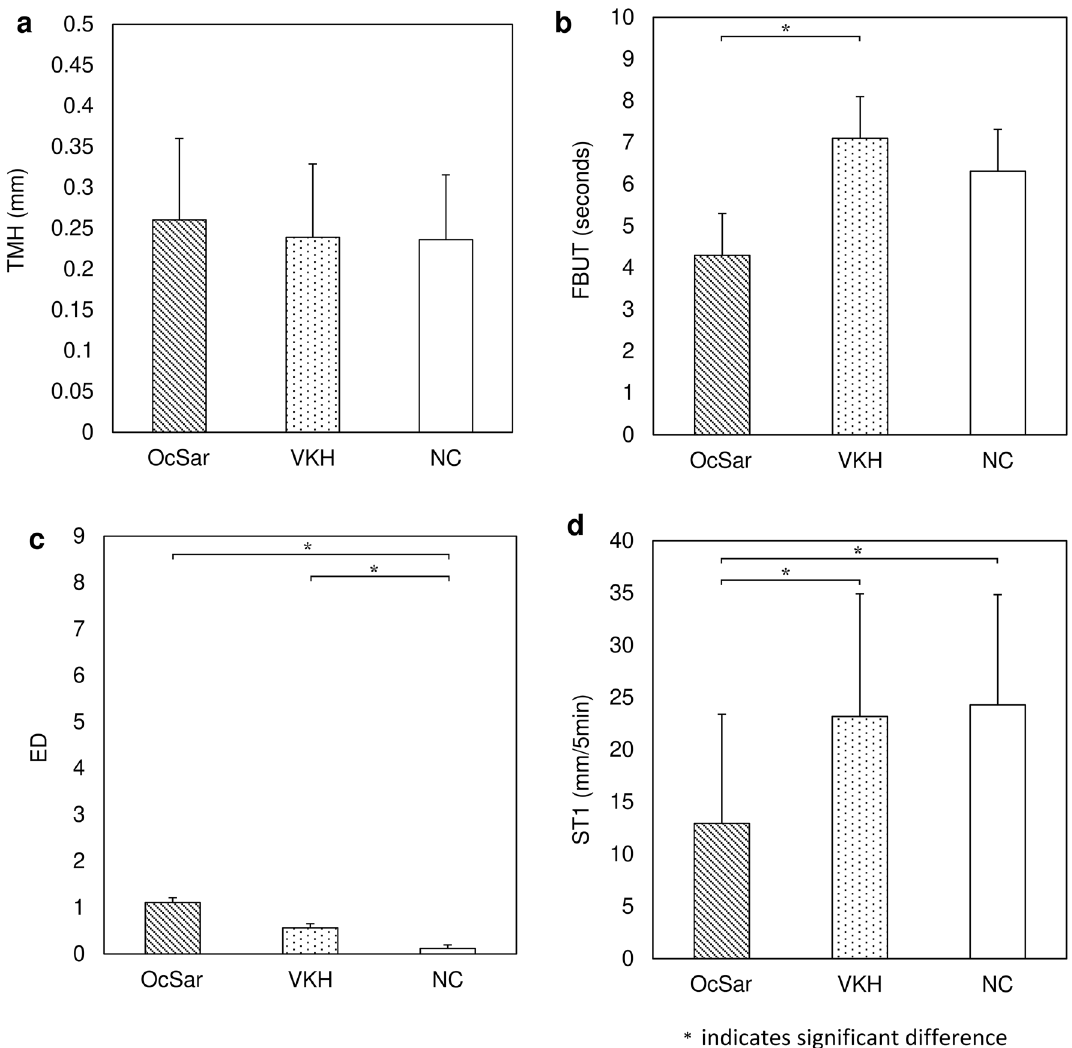
Figure 1. ( a ) Comparison of tear meniscus height (TMH, mm) between the ocular sarcoidosis (OcSar) group (0.26 ± 0.10 mm), Vogt–Koyanagi–Harada disease (VKH) group (0.24 ± 0.09 mm), and normal control (NC) group (0.24 ± 0.08 mm) (all values are mean ± SD). No statistical difference was found. ( b ) Comparison of fluorescein breakup time (FBUT, seconds) between the OcSar group (4.3 ± 2.5 s), VKH group (7.3 ± 2.9 s) and OcSar group (6.3 ± 3.1 s) (all values are mean ± SD). Significant differences were found between the one of 3 groups [ P = 0.002 (OcSar vs. VKH), P = 0.057 (OcSar vs. NC), and P = 0.527 (VKH vs. NC)]. ( c ) Comparison of keratoconjunctival epithelial damage (ED) between the OcSar group (1.1 ± 1.1), VKH group (0.7 ± 0.8), and NC group (0.1 ± 0.3) (all values are mean ± SD). There were significant differences between the two of 3 groups [ P = 0.358 (OcSar vs. VKH), P = 0.001 (OcSar vs. NC), and P = 0.040 (VKH vs. NC)]. ( d ) Comparison of the Schirmer 1 test results (ST1, mm/5 min) between the OcSar group (12.9 ± 10.5 mm), VKH group (21.5 ± 12.1 mm), and NC group (24.3 ± 10.5 mm) (all values are mean ± SD). The ST1 values in the OcSar group were significantly lower than those in the VKH group and NC group [ P = 0.004 (OcSar vs. VKH), P = 0.001 (OcSar vs. group (7.3 ± 2.9 s) ( P = 0.002), yet no significant difference in mean FBUT was found between the OcSar group (4.3 ± 2.5 s) and the NC group (6.3 ± 3.1 s) ( P = 0.057) (Fig. 1b). There was no significant difference in the mean ED value between the OcSar group (1.1 ± 1.1) and the VKH group (0.7 ± 0.8) ( P = 0.358). The mean ED value in the OcSar group (1.1 ± 1.1) was significantly higher than that in the NC group (0.1 ± 0.3) ( P = 0.001), and the mean ED value in the VKH group was significantly lower than that in the NC group ( P = 0.040) (Fig. 1c). The mean ST1 value in the OcSar group (12.9 ± 10.5 mm) was significantly lower than that in the VKH group (21.5 ± 12.1 mm) and NC group (24.3 ± 10.5 mm) [ P = 0.004 (OcSar vs. VKH), P = 0.001 (OcSar vs. VKH)] (Fig. 1d). The rate of the cases with ST1 values being 5 mm or less was 8/27 (29.6%) in the OcSar group, 1/18 (5.6%) in the VKH group, and 0/17 (0%) in the NC group. The rate of cases with ST1 values of ≤ 5 mm was analyzed among 2 groups each by Fisher’s exact test. The rate of cases in each group with ST1 values of ≤ 5 mm was significantly higher in the